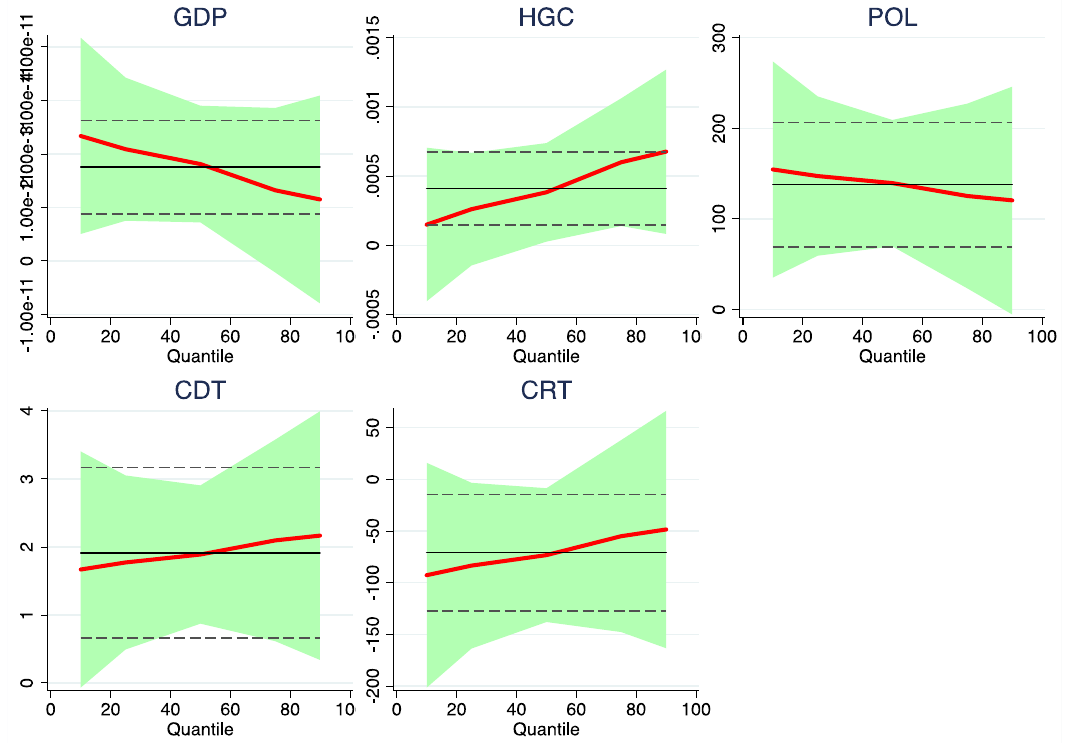
Figure 4. The quantile estimate: Shaded areas are (95%) confidence bands for the quantile regression estimates. The command qregplot, with option ols olsopt(abs(municipality) robust) q(10 25 50 75 90) of Stata 17.0, was